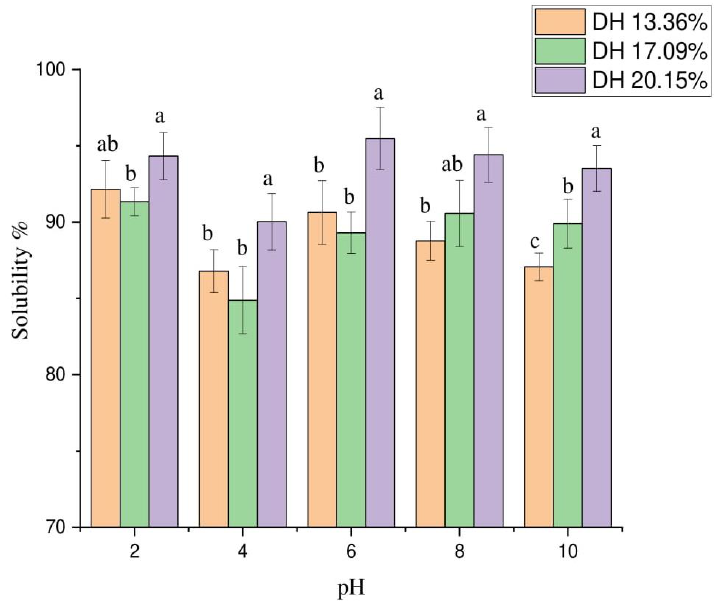
Figure 6. Protein solubility of hydrolysates at different degrees of hydrolysis at pH 2–10. Values represent mean ± SD ( n = 3), and various letters indicate that values are significantly different ( p ≤ 0.05).